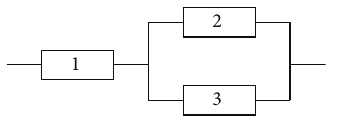
Figure 1: A lighting lamp